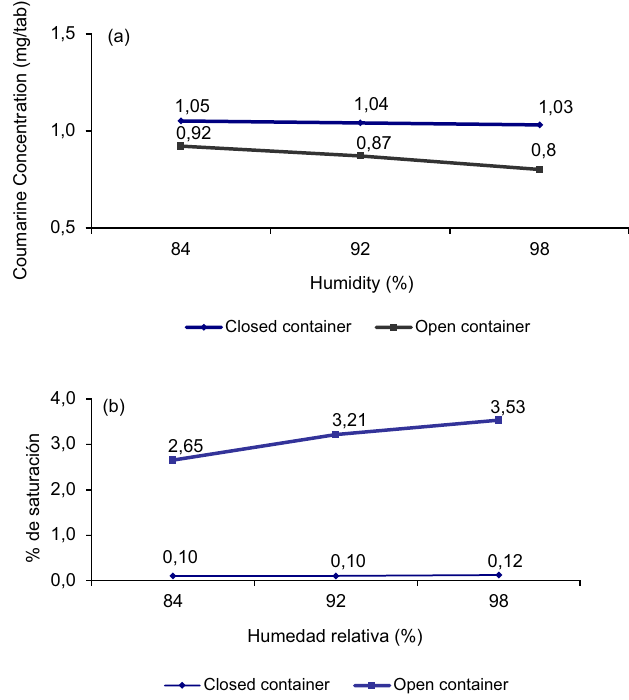
FIGURE 3 - Analytic results up to 180 days under different humidity conditions (a) Coumarin content and (b) % of